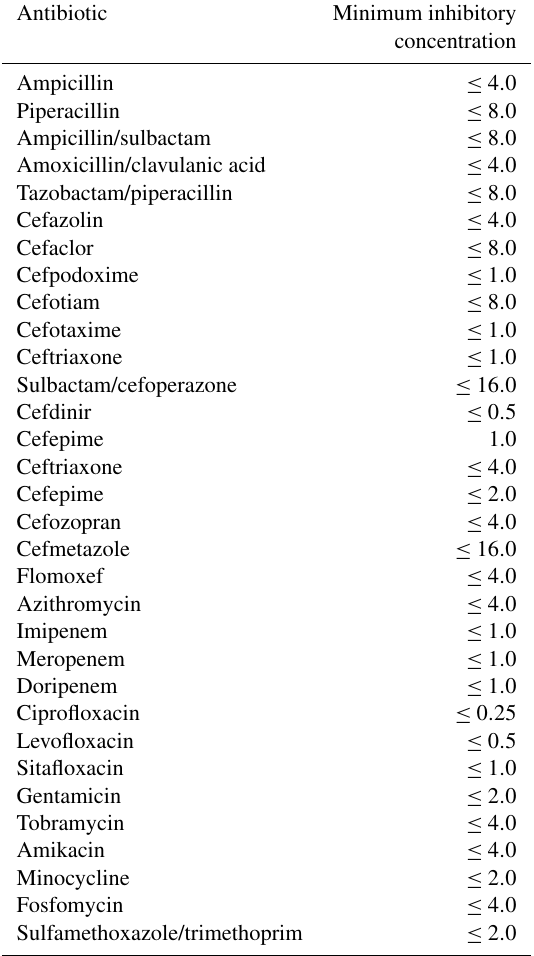
Table 1. Microbiologic susceptibility panel.